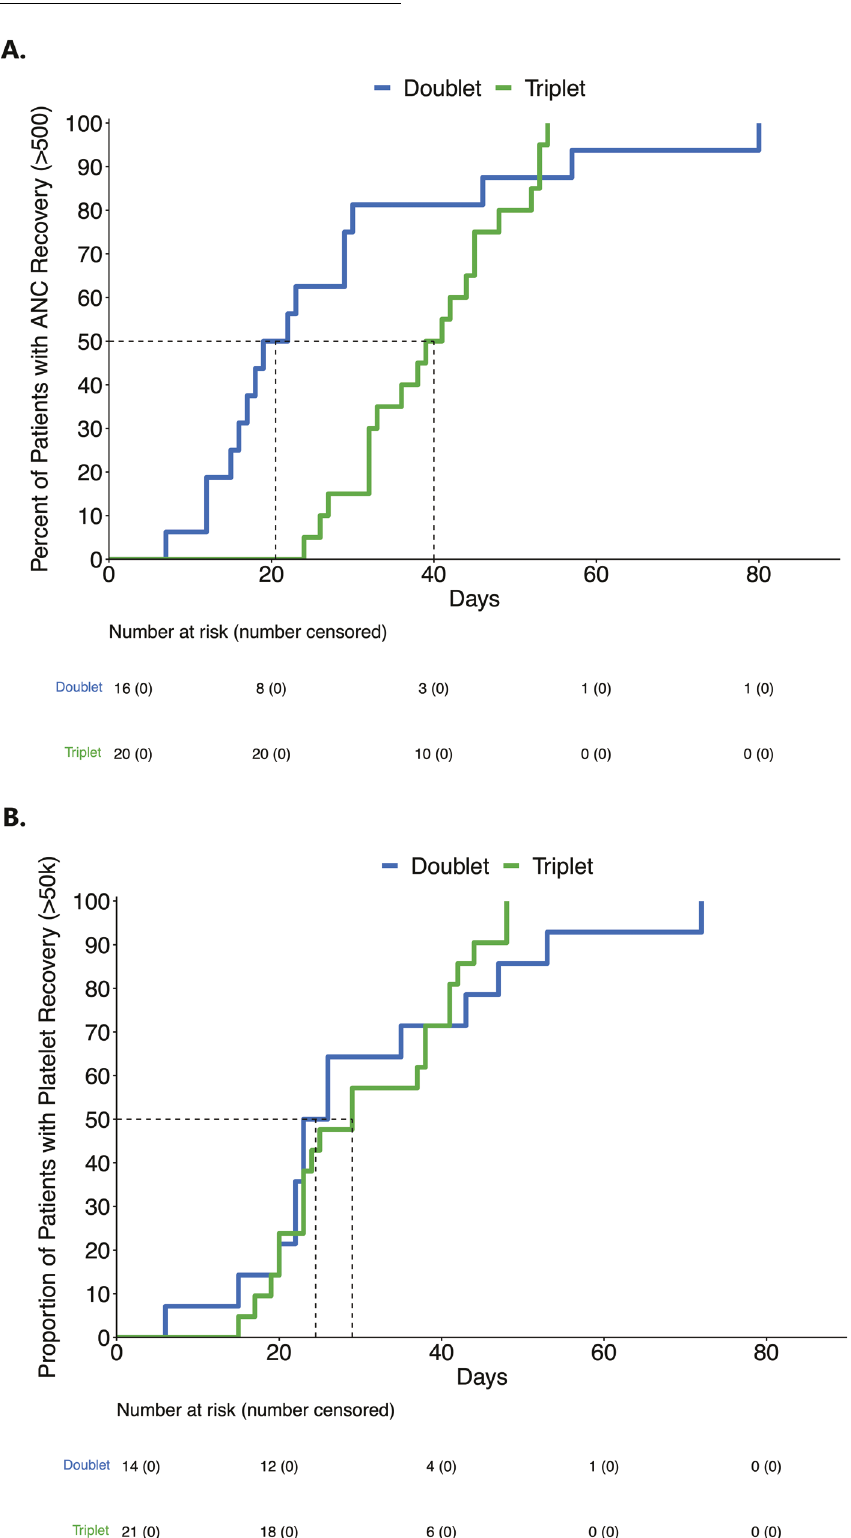
Fig. 3 Time to neutrophil (A) and platelet recovery (B) at the end of cycle 1 with doublet vs. triplet regimens. A T he median time to absolute neutrophil count (ANC) > 500/mm 3 is 21 days (95% CI: 16 – 46 days) in the doublet group and 40 days (95% CI: 33 – 48 days) in the triplet group, HR 1.68 (95% CI: 0.83 – 3.41), p = 0.15. B The median time to platelet > 50,000 microliter is 25 days (95% CI: 22 – 53 days) in the doublet group and 29 days (95% CI: 23 – 41 days) in the triplet group. HR 0.84 (95% CI: 0.41 – 1.72), p = 0.6. ANC absolute neutrophil count (per mm 3 ); Platelet (per microliter); 50k,